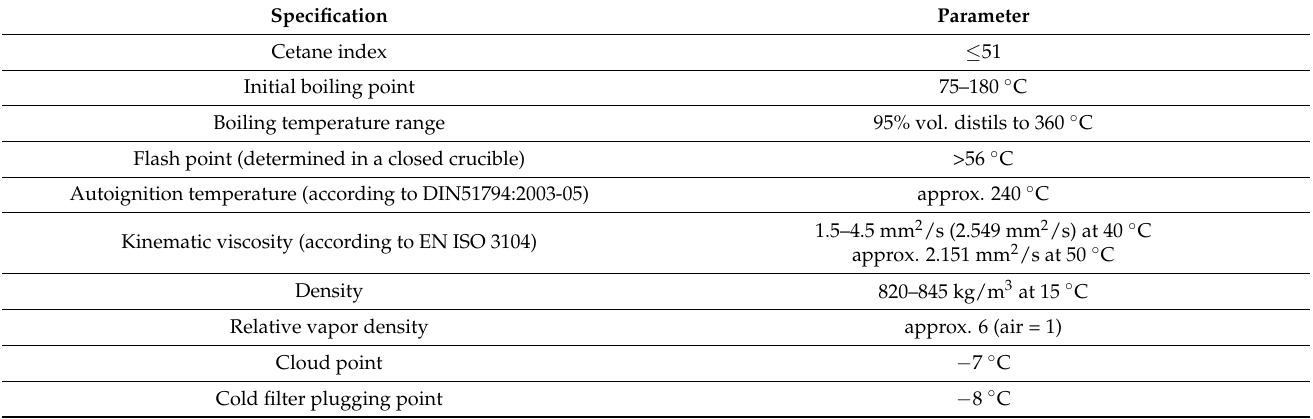
Table A4. Manufacturer-declared physicochemical properties of Agip Cladium 120 CD lubricating oils used in tests [61–63].